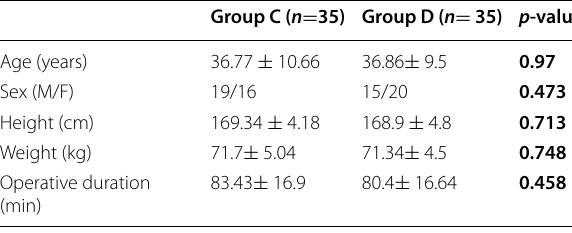
Data are presented as mean p -value > 0.05 is considered statistically